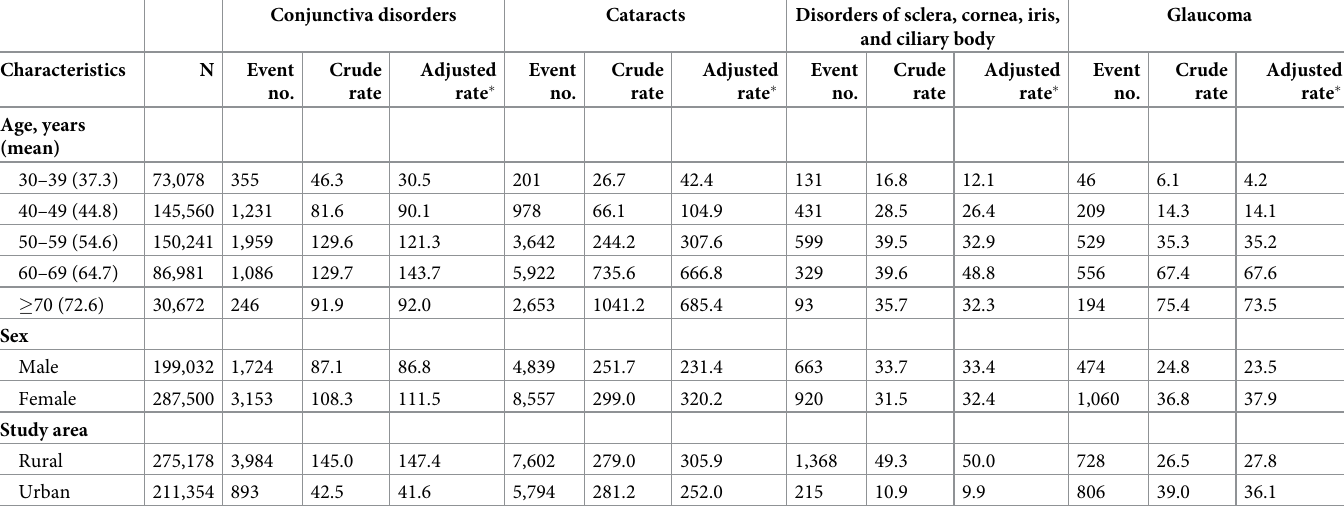
Table 2. Distribution and rates (per 100,000 person-years) of eye disease examined according to age, sex, and study